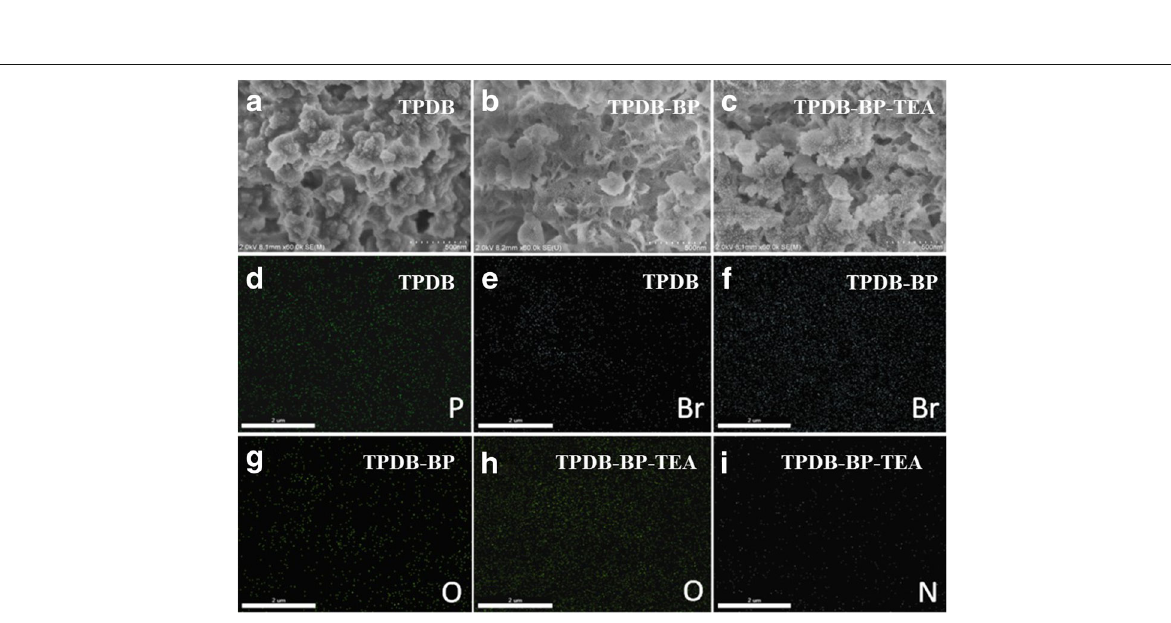
Fig. 4 SEM and EDS mapping images of a , d , and e TPDB, b , f , and g TPDB-BP, and c , h , and i TPDB-BP-TEA. TPDB, TPDB-BO, and TPDB-BP-TEA all show amorphous morphology ( a ). After the modification with BP and TEA, TPDB-BP-TEA shows no main changes in the structure, but its surface became rough with some agglomerated blocks ( c ). EDS mapping image validates the homogeneous distribution of P and Br elements in the polymer framework of TPDB ( d , e ). The amount of Br increased obviously ( f ), and a new element O was observed ( g ) after the modification of TPDB with BP. After the further modification of TPDB-BP with TEA, a new element N was observed ( i ), and the amount of O element increased significantly in the image of TPDB-BP-TEA ( h ). These images confirm the successful immobilization of BP and TEA on the TPDB